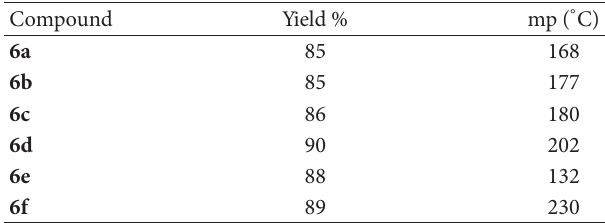
T 3: Yield and melting points of dicarboxylic acids 6a–f C) ∘